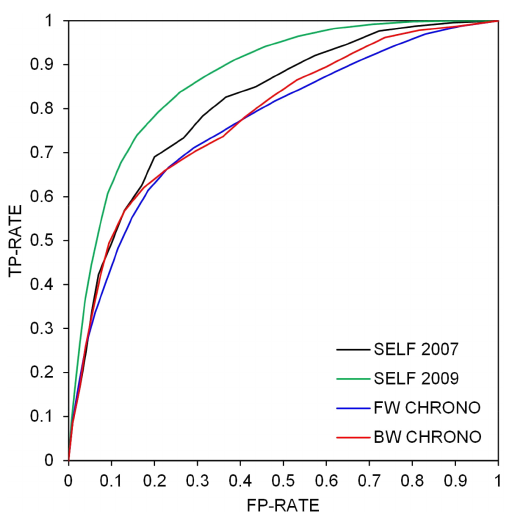
Figure 12. Comparison of the mean ROC curves obtained for the self-validated and chrono-validated